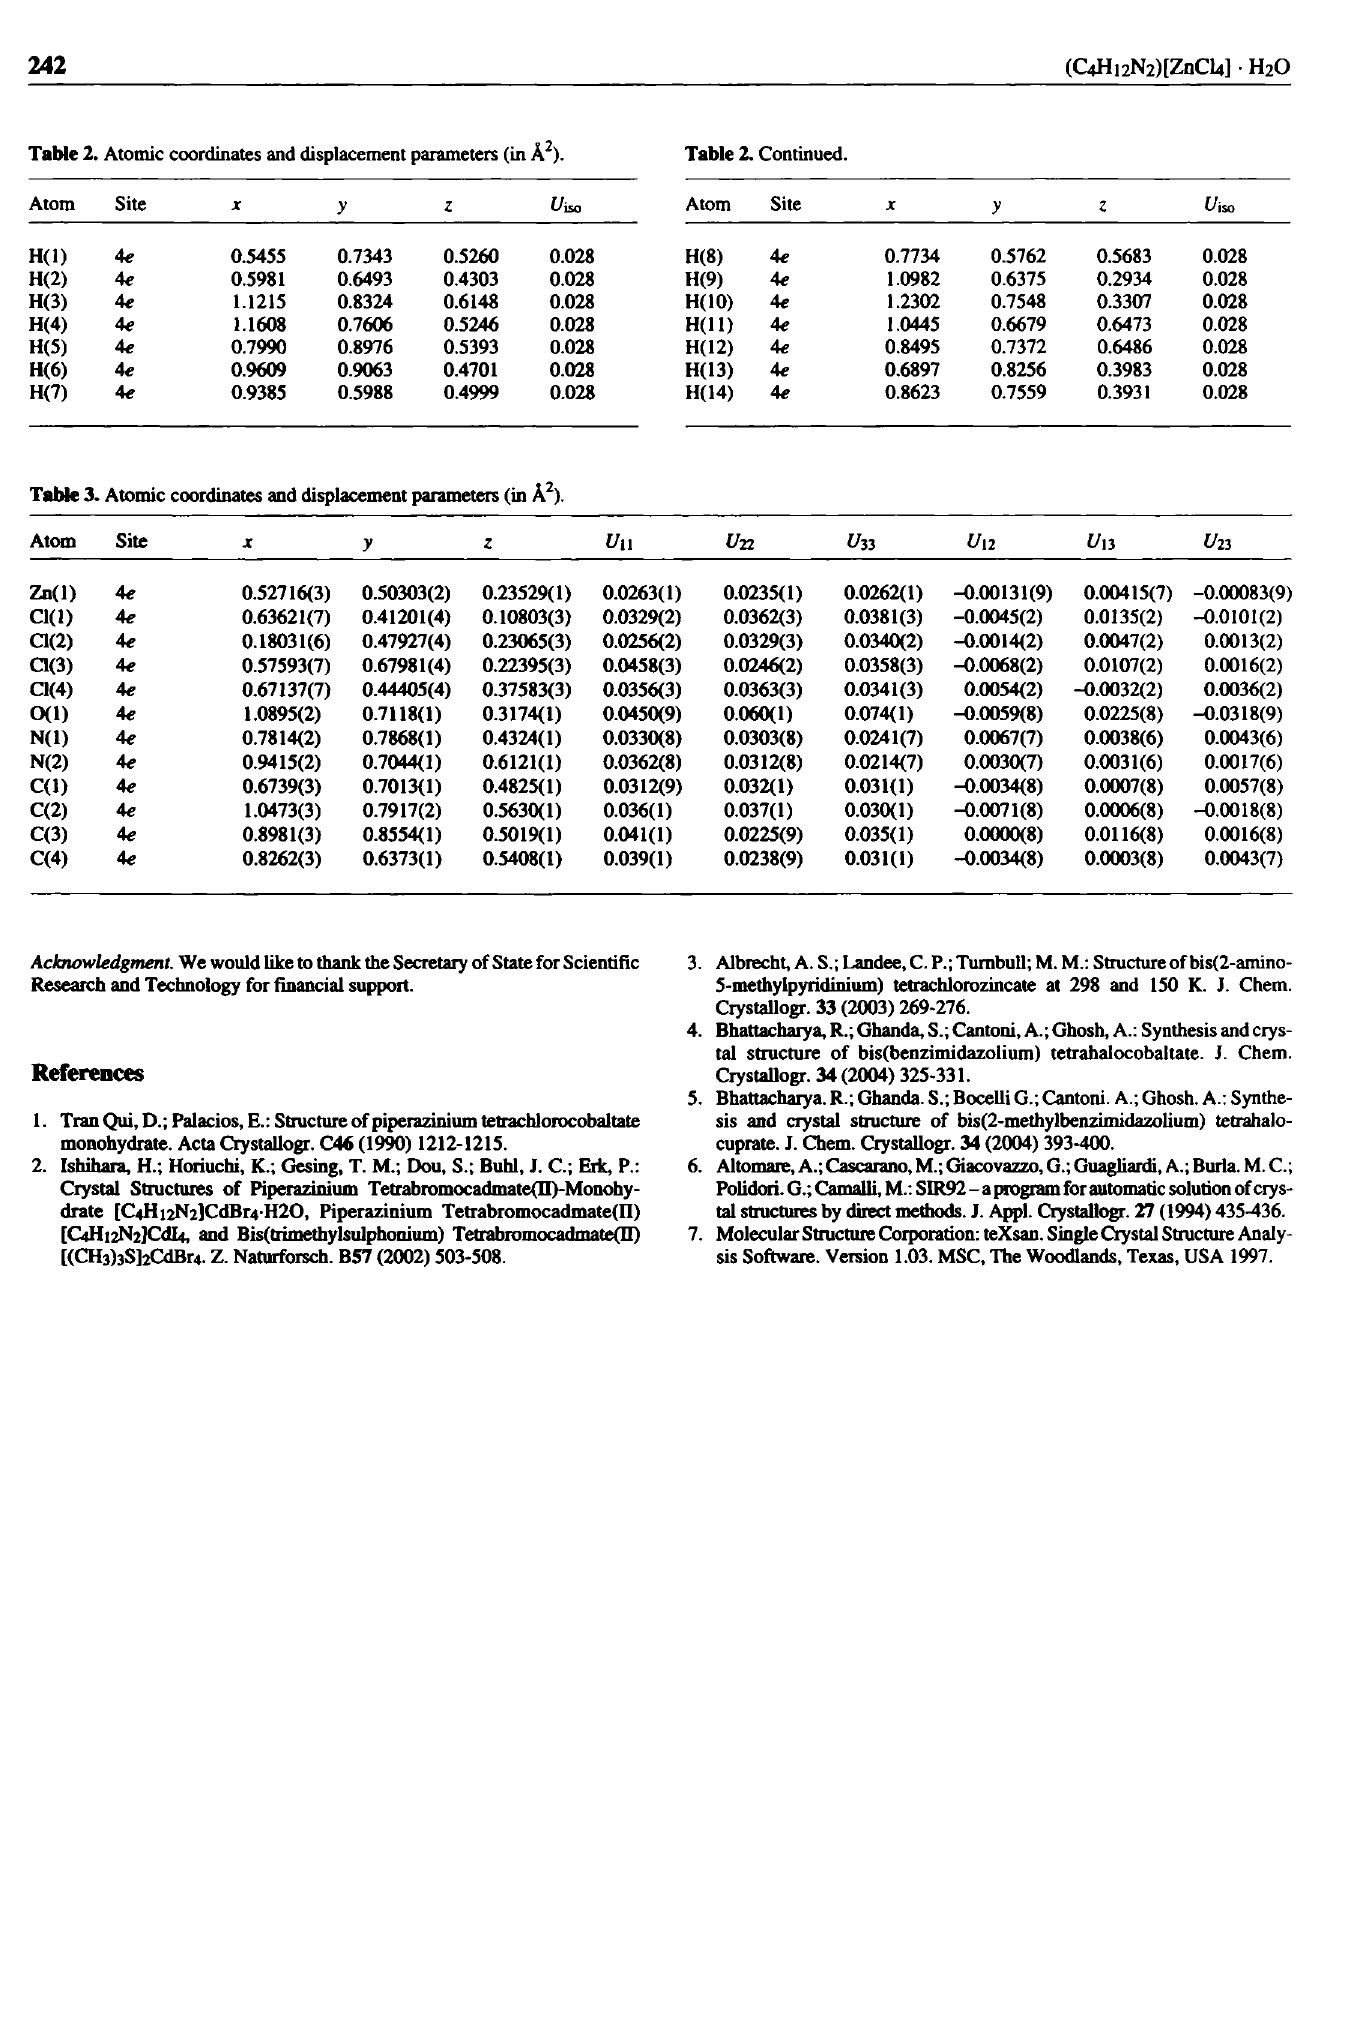
Table 2. Atomic coordinates and displacement parameters (in Ä 2 ).